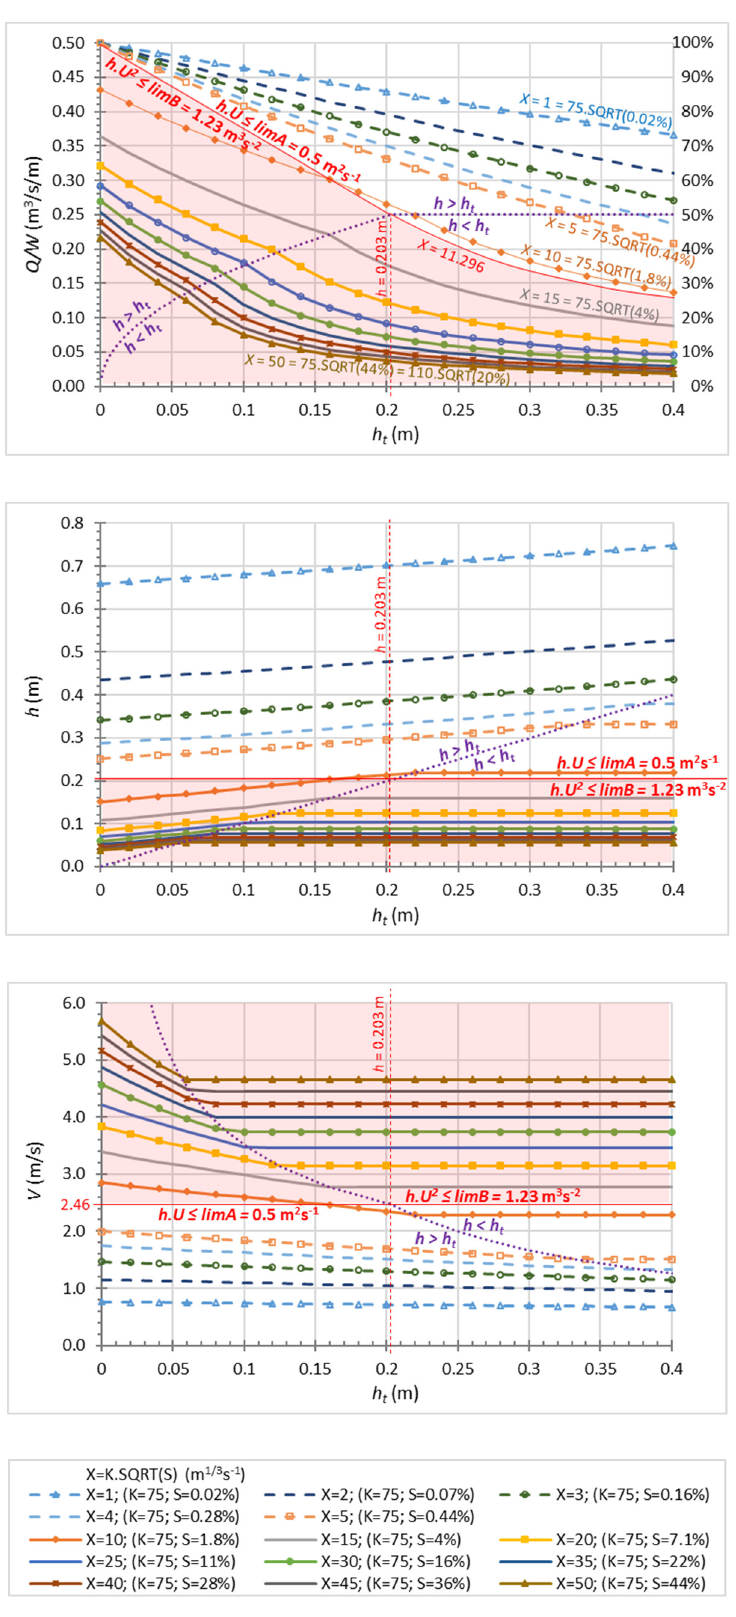
Figure 3. Variations of h , V and Q / W fulfilling the thresholds of both criteria h . V = 0.5 m 2 s − 1 and h . V 2 = 1.23 m 3 s − 2 , as a function of h t and K . S